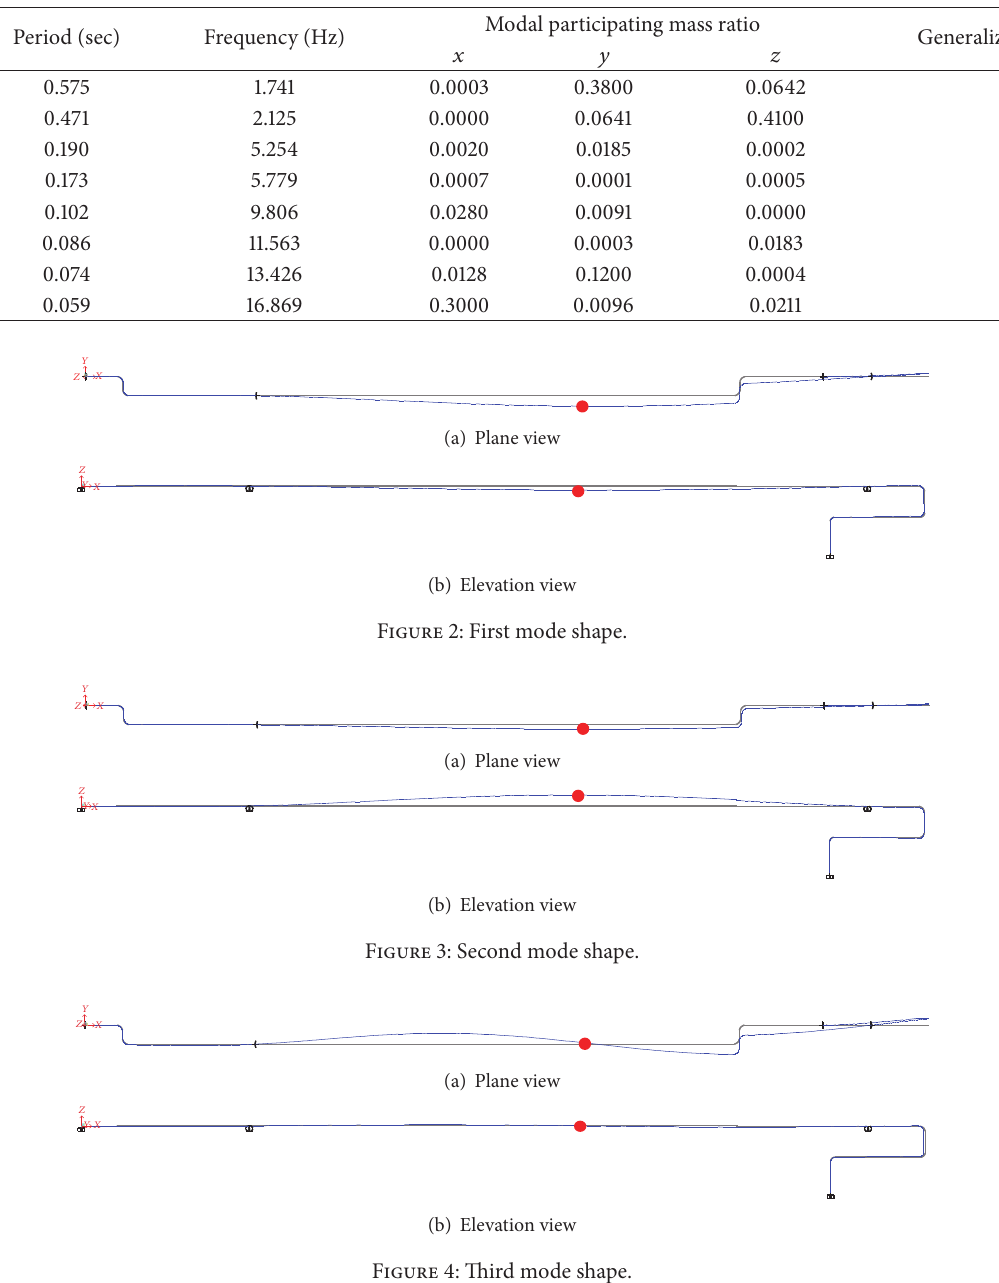
Table 3: Dynamic properties of the piping